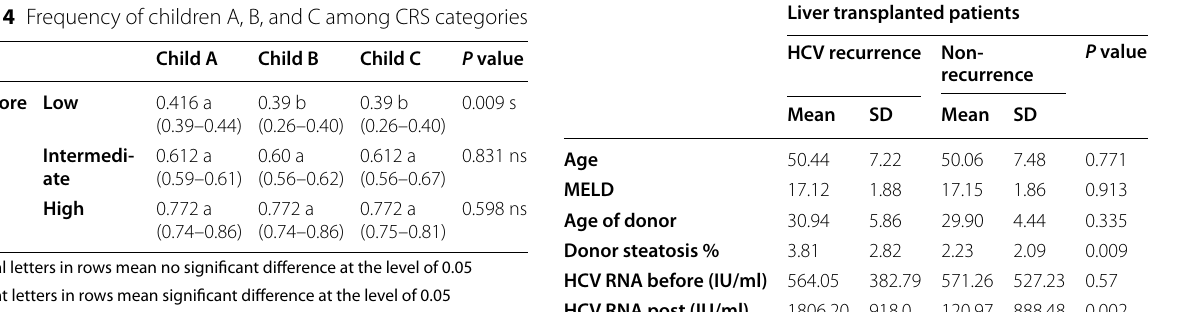
Table 4 Frequency of children A, B, and C among CRS categories